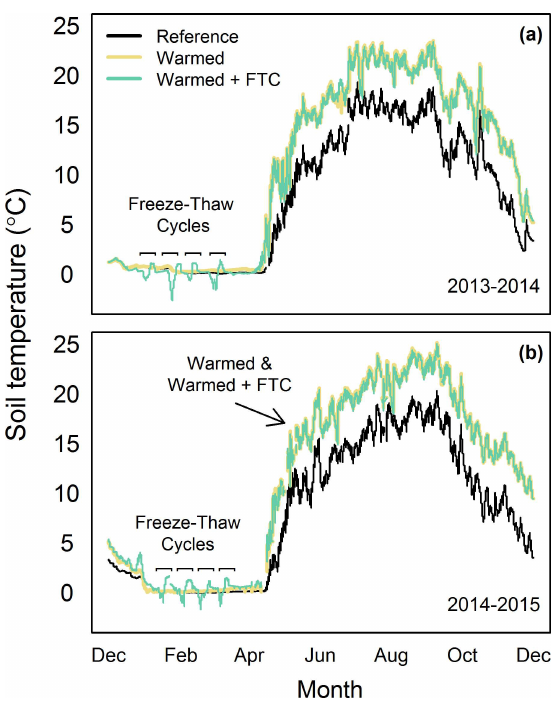
Fig 2. Soil temperatures from a) December 2013 to December 2014 and b) December2014 to December2015. Soil temperatures averagedby treatment for 10 cm depth thermistors for each